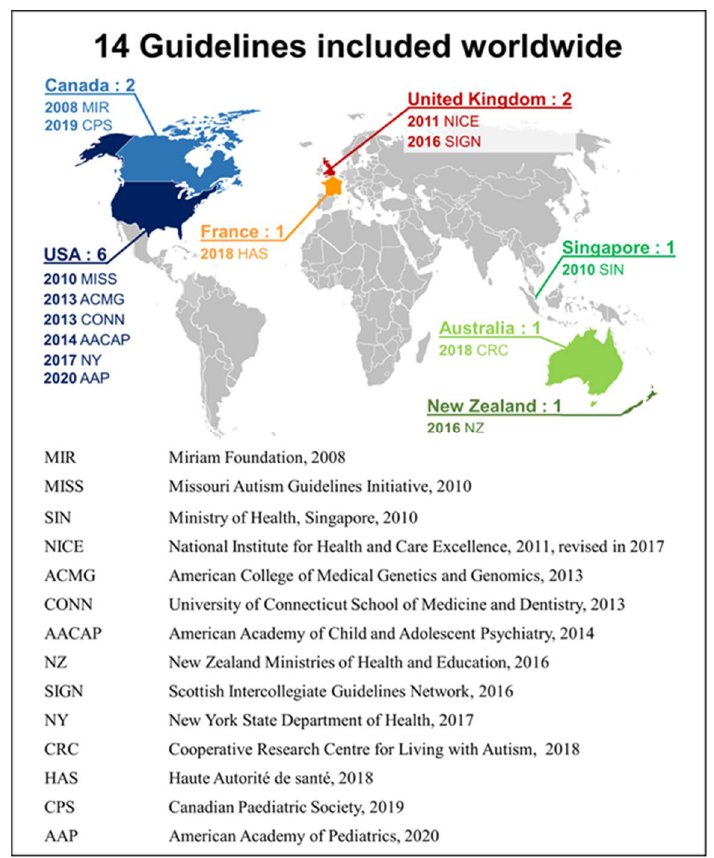
Figure 2. CPGs included and their country of